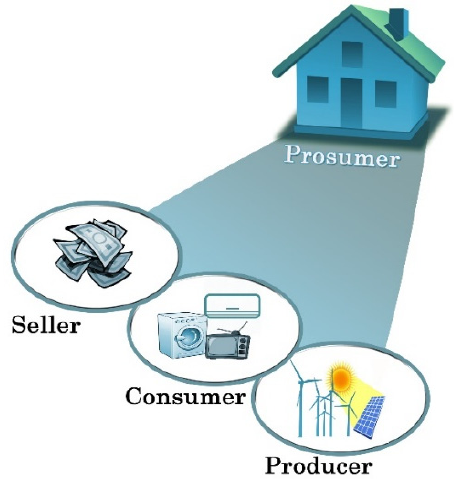
Figure 1. Three major roles of a prosumer.